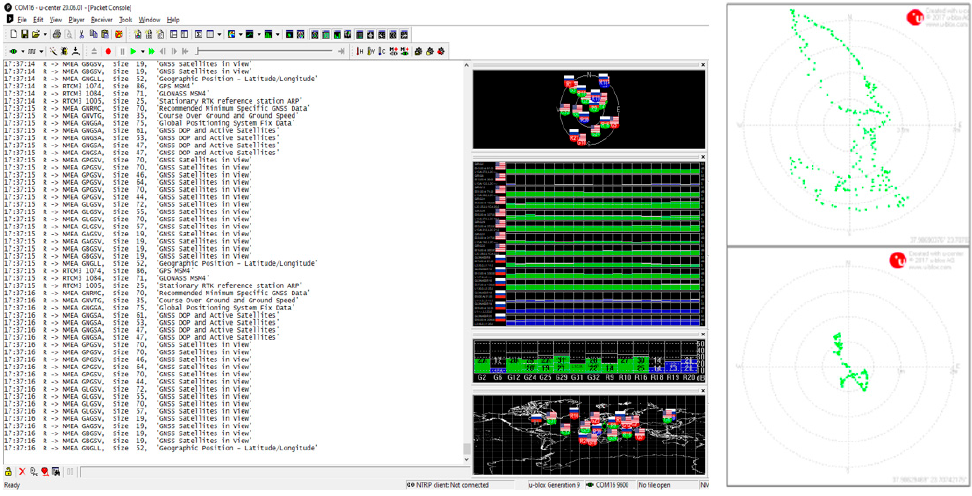
Figure 9. GPS module performance inspection and adjustments, using the u-blox environment for u-blox chip-based devices, via a USB connection.